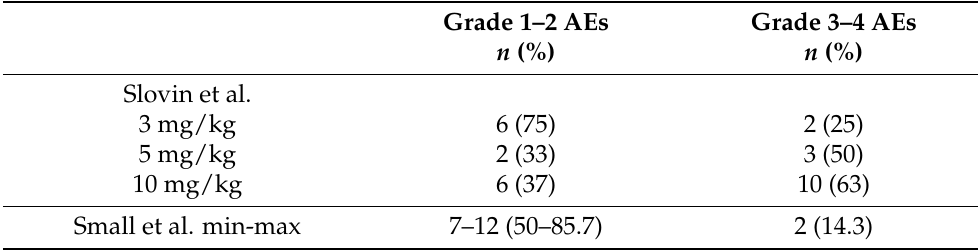
Table 1. Percentages of AEs registered in prostate cancer patients subject to ipilimumab therapy [22,23]. The two columns Grade 1–2 AEs and Grade 3–4 AEs represent the magnitude of the side effects, which is grade 1 and 2, and grade 3 and 4, respectively. The data are expressed in terms of number of patients and corresponding percentages ( p M and p S in the Equation (2)). In Small et al., severe AEs were only of grade 3, and their number is clearly reported, while we infer a possible range of patients presenting AEs of grade 1 and